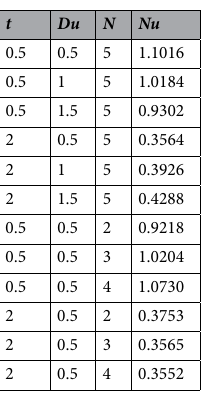
Table 1. Computational values of Nusselt number for various t, Du and N when Pr = 0.71, Sc = 0.22, K = 0.5, t 1 =